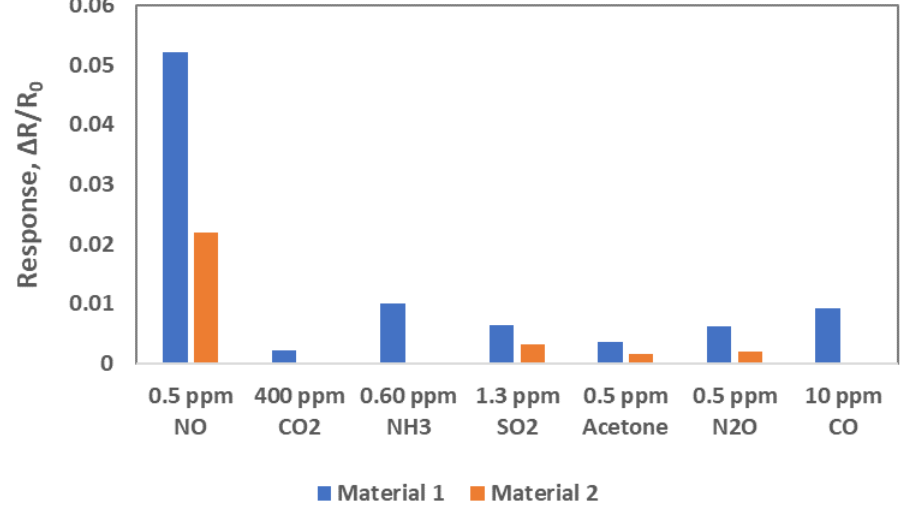
Figure 8. Comparison of sensitivity for Material 1 and Material 2 sensors to commonly interfering concentration of CO 2 , NH 3 , SO 2 , acetone, N 2 O and CO gases at room temperature in air background.